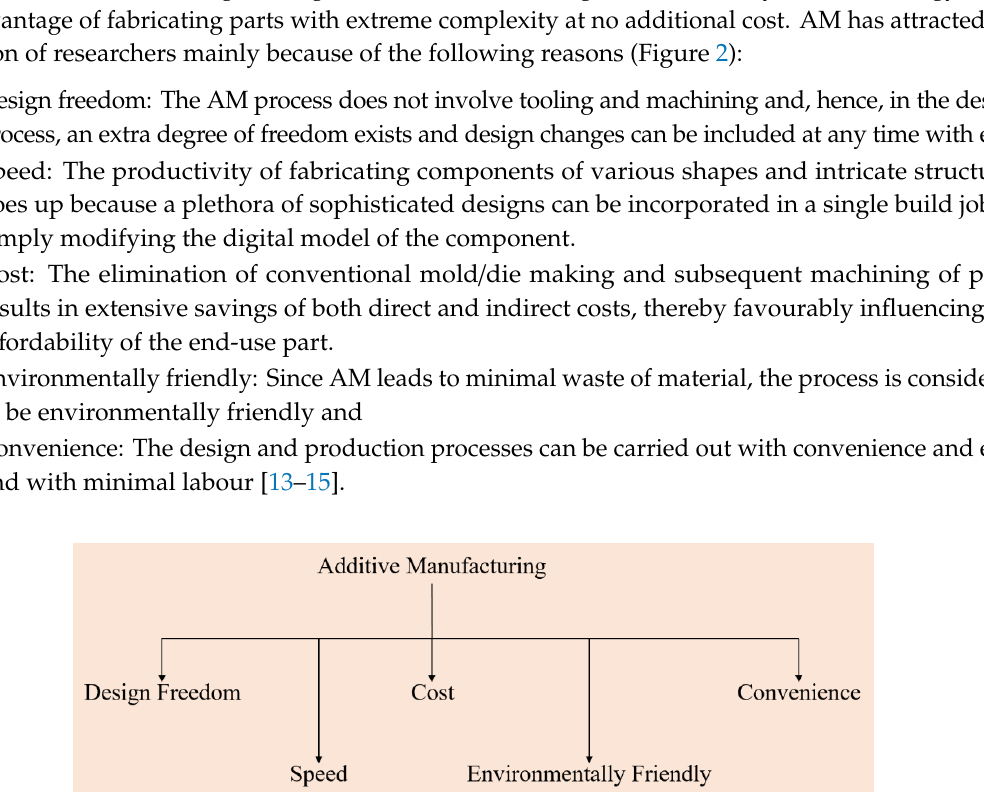
Figure 2. Schematic illustration showing the advantages of additive manufacturing in fabricating parts.